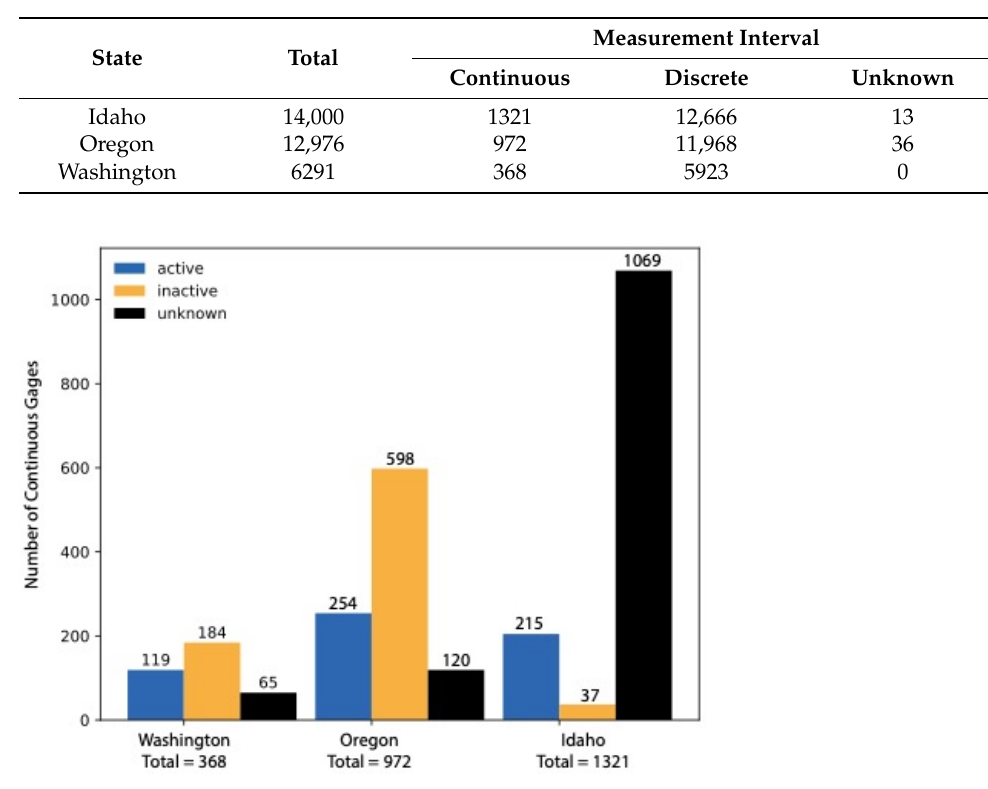
Table 2. Status of continuous monitoring locations recorded in the Streamflow Data Catalog in each state.